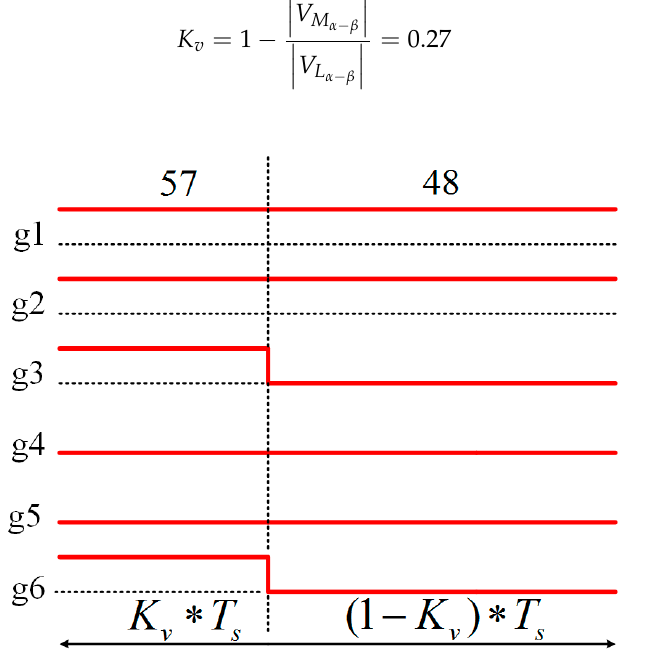
Figure 3. Switching pattern.